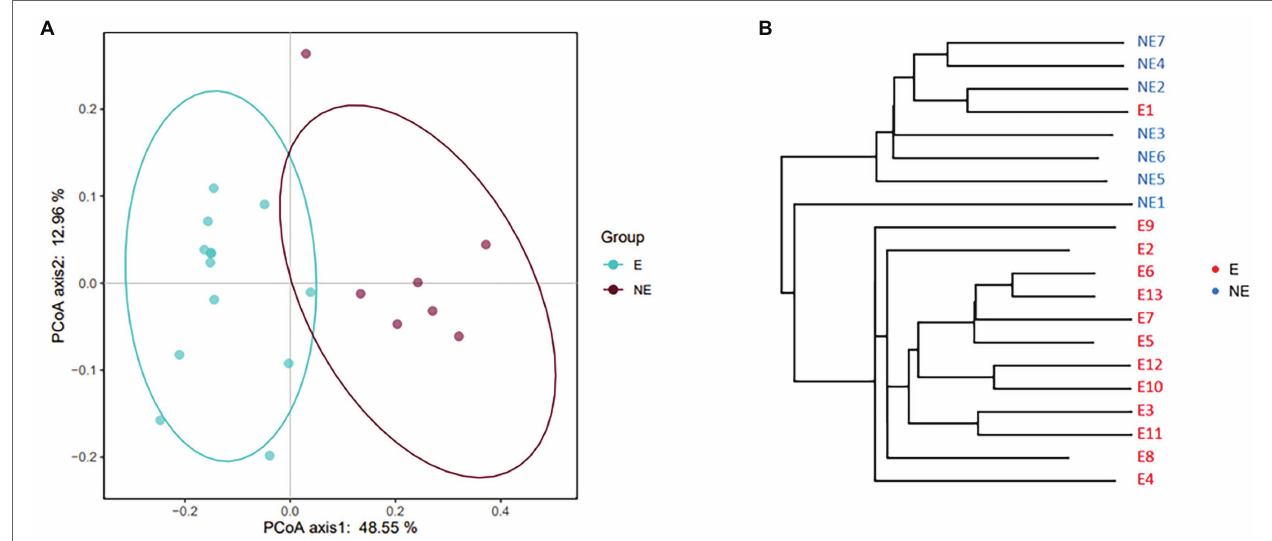
FIGURE 2 | (A) PCoA based on the distance matrix (distance other than Euclidean distance) to find principal coordinates. (Description) X -axis, PCoA axis1 and Y axis, PCoA axis2. The scale of the X -axis and the Y -axis are the projection coordinates of the sample points in the two-dimensional plane, respectively. A dot represents each sample, and different colors represent different groups. (B) Samples Clustering result (Description, weighted_unifrac). The same color represents the samples in the same group. Short distance between samples represents high